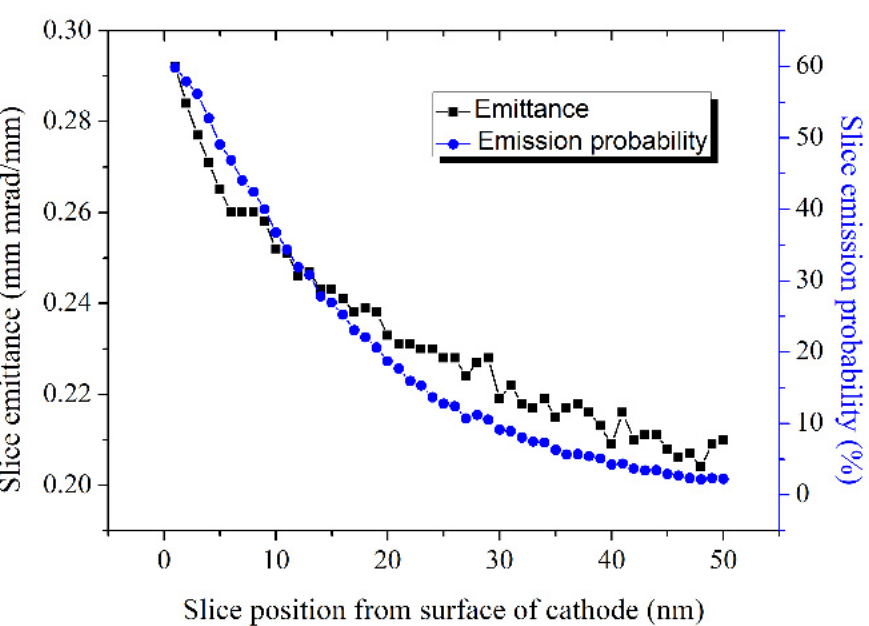
Figure 12. The black line shows the simulated intrinsic emittance of K 2 CsSb photocathode with the assumption that all electrons are emitted from one slice (thickness is 1 nm). The blue line indicates the emission probability [47].